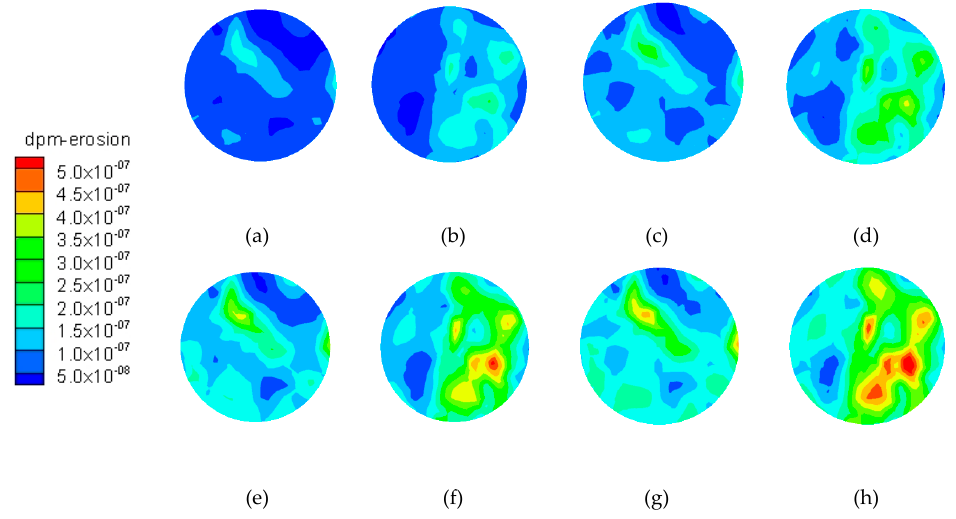
Figure 14. Wear contours of test samples with different particle volume fraction: (a) condition set 5, 225mm; (b) condition set 5, 316mm; (c) condition set 6, 225mm; (d) condition set 6, 316mm; (e) condition set 7, 225mm; (f) condition set 7, 316mm; (g) condition set 8, 225mm; (h) condition set 8, 316mm.